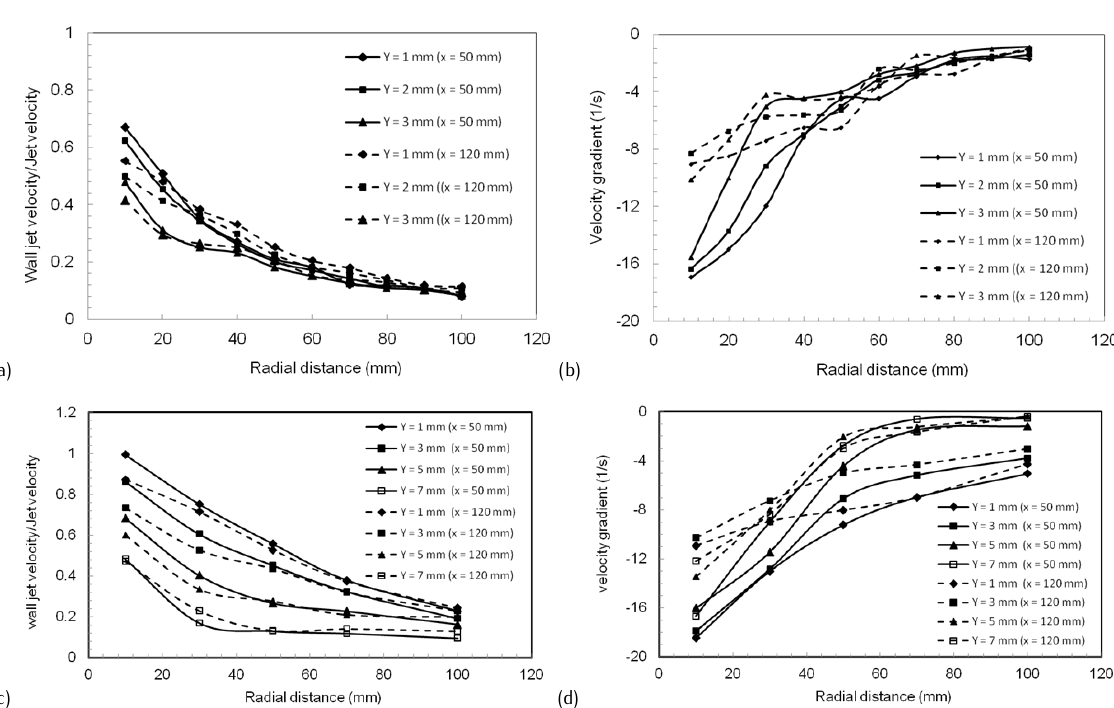
Figure 6. (a) Variation of wall jet velocity/jet velocity ratio with radial distance for X = 50 & 120 mm at three different distances from the plate surface ( d = 10 mm ) ; (b) Variation of velocity gradient with radial distance for X = 50 & 120 mm at three different distances from the plate surface ( d = 10 mm ) ; (c) Variation of wall jet velocity/jet velocity with radial distance for X = 50 & 120 mm at three different distances from the plate surface ( d = 20 mm ) ; (d) Variation of velocity gradient with radial distance for X = 50 & 120 mm at three different distances from the plate surface ( d = 20 mm )